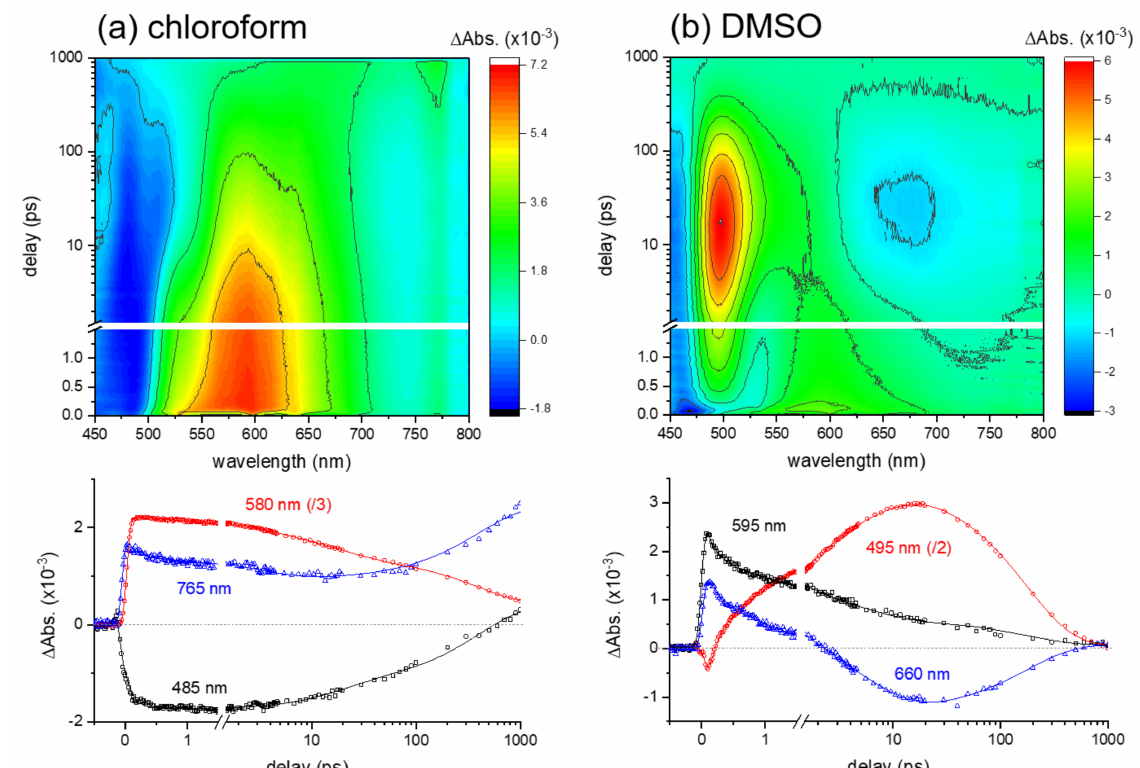
Figure 2. Surface plots and kinetics of excited-state absorption (ESA) and stimulated emission (SE) bands in transient absorption results of curcumin in ( a ) chloroform and ( b ) dimethyl sulfoxide (DMSO) obtained with 403 nm